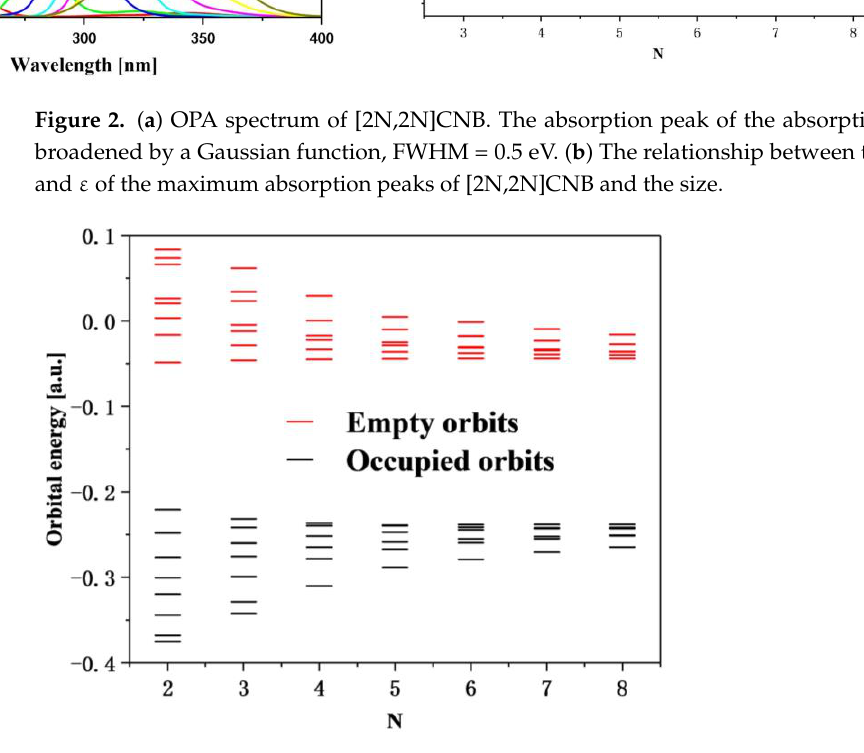
Figure 3. Energy levels of the 10 highest occupied orbitals and the 10 lowest empty orbitals in [2N,2N]CNB.